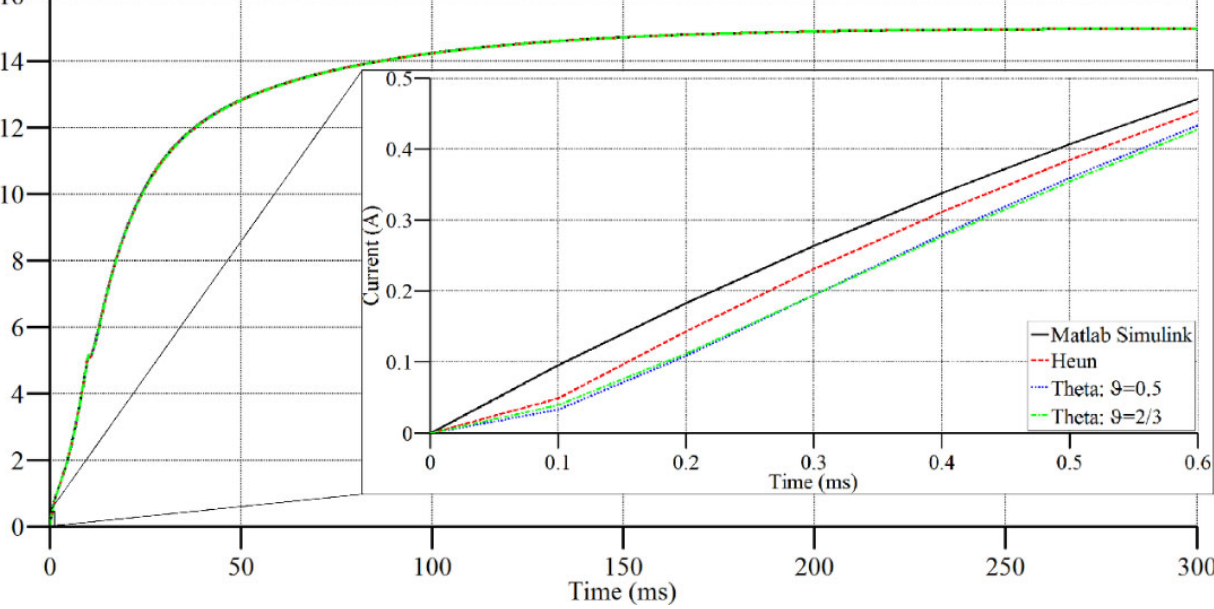
Figure 4. First branch current during the 0–0.6 ms time interval.